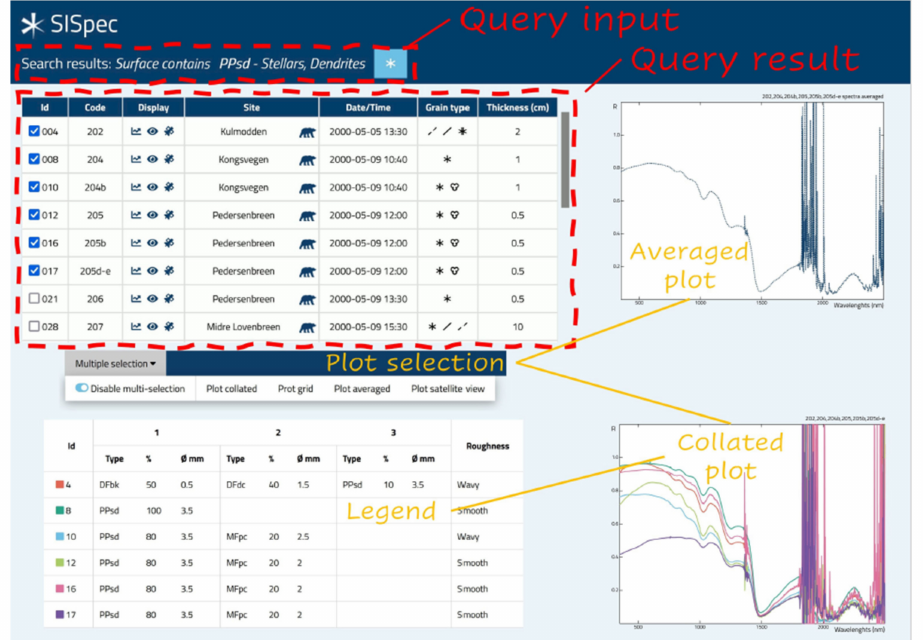
Figure 6. Results of the query by grain type PPsd with spectrum visualization and multiple selection. Information sections rearranged for